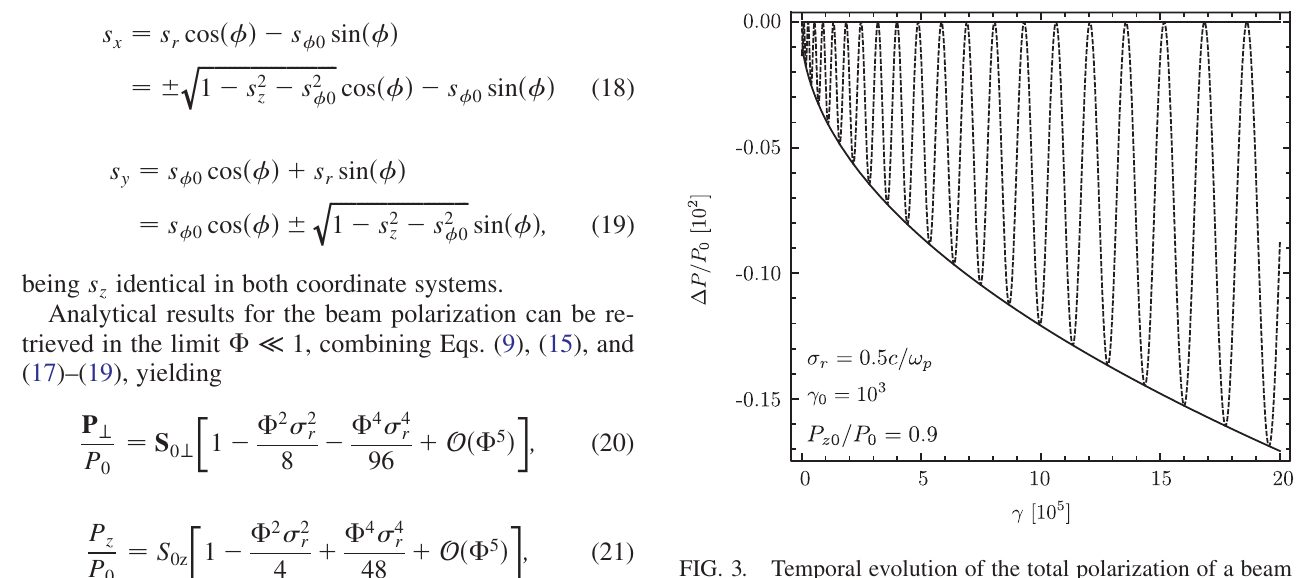
FIG. 3. Temporal evolution of the total polarization of a beam which accelerates from 0.5 GeV ( (cid:3) 2 (cid:1) 10 6 ), considering P the upper and lower envelopes (cid:3) P=P sent the evolution of (cid:3) P=P